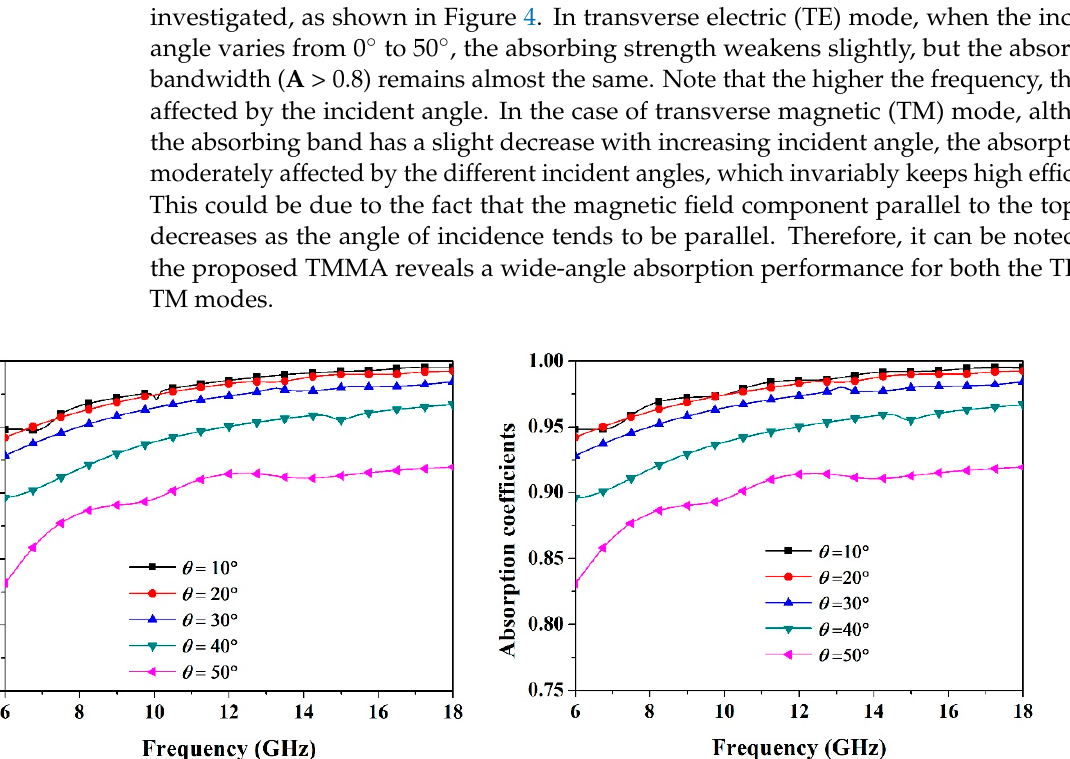
Figure 3. Absorption coefficients and reflection/transmission coefficients. ( a ) Absorption coeffi- cients. ( b ) Reflection coefficients. ( c ) Transmission coefficients.